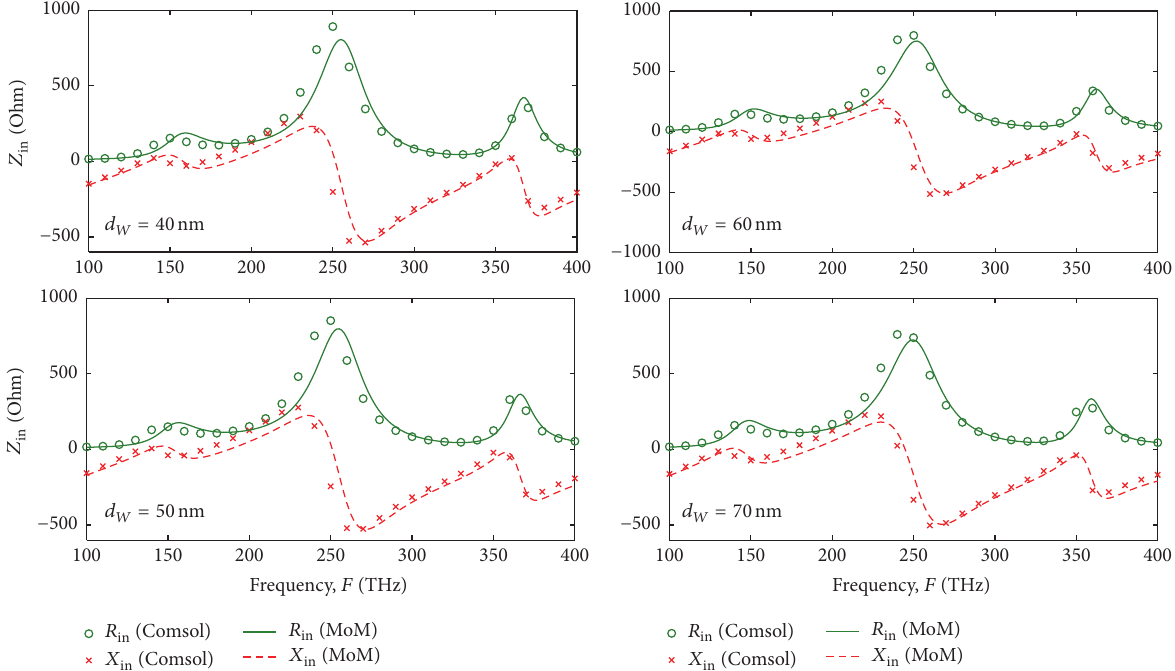
Figure 11: Input impedance of the composed nanoantenna for 𝑑 𝑊 = 40, 50, 60, and 70 nm and 𝑑 𝐻 =